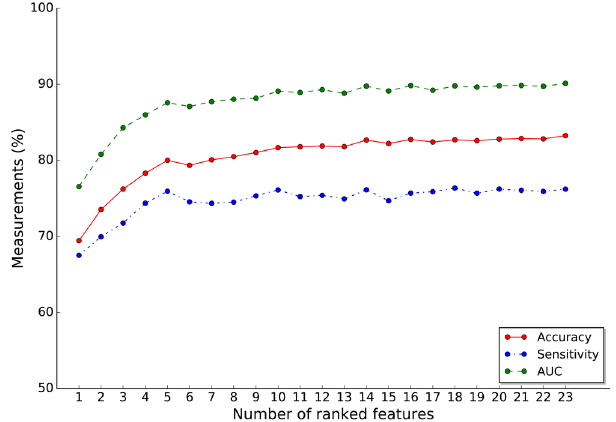
Figure 2. Classification accuracy, sensitivity and AUC of the random forest model along with the number of considered features. AUC, areas under curve.